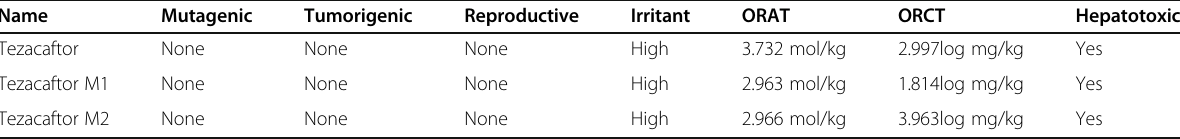
Table 20 Predicted molecular toxicity of Tezacaftor and its metabolites using data warrior Name